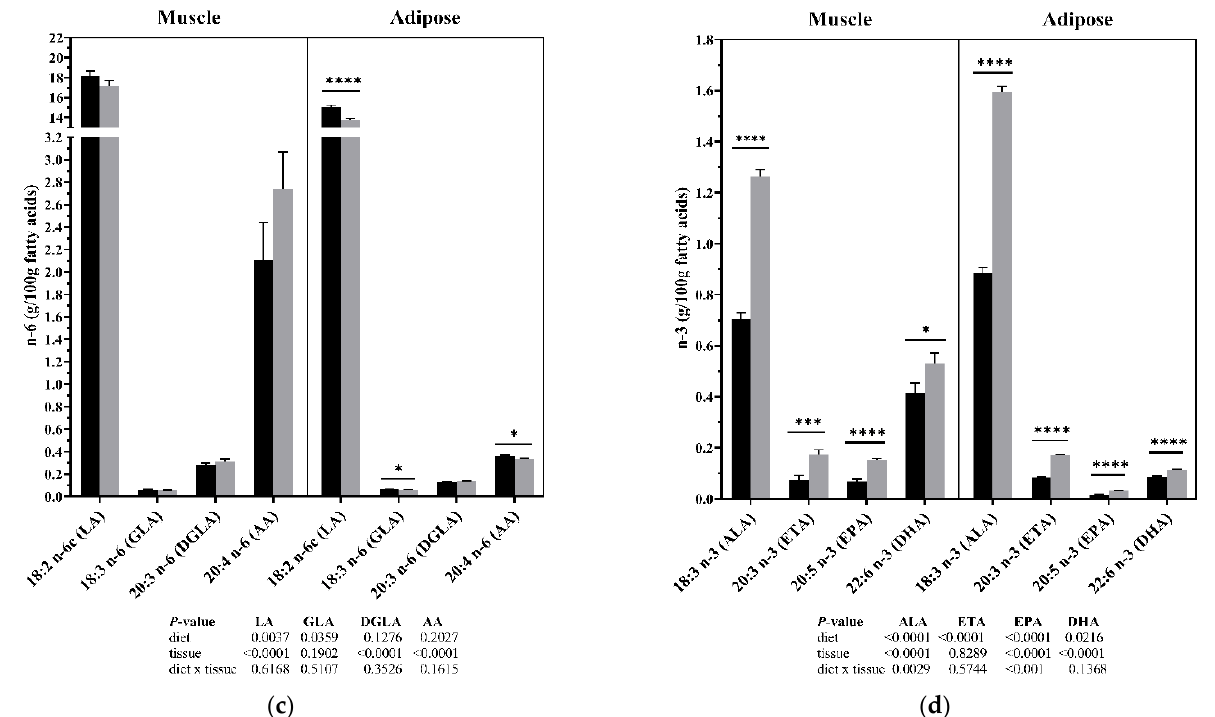
Figure 1. Fatty acid profile of muscle and adipose tissue samples for SOY and LIN diets. ( a ) Sum of saturated fatty acids (SFAs), monounsaturated fatty acids (MUFAs), and polyunsaturated fatty acids (PUFAs); ( b ) total n-6, n-3, and the n-6/n-3 polyunsaturated fatty acid ratio; ( c ) major n-6 polyunsaturated fatty acid profile (linoleic acid, LA ; gamma γ -linoleic acid, GLA ; dihomo-gamma γ -linolenic acid, DGLA ; arachidonic acid, AA ); ( d ) major n-3 polyunsaturated fatty acid profile (alpha α -linolenic acid, ALA ; eicosatrienoic acid, ETA ; eicosapentaenoic acid, EPA ; decosahexaenoic acid, DHA ). Data are presented as LSM ± SE; significance levels: * = p < 0.05, *** = p < 0.001, **** = < 0.0001, no label = not significant, p > 0.05; n = 24 piglets for each SOY and LIN group. Table 3. Differentially expressed proteins * from muscle tissue, protein-coding genes, and their abundance ratio